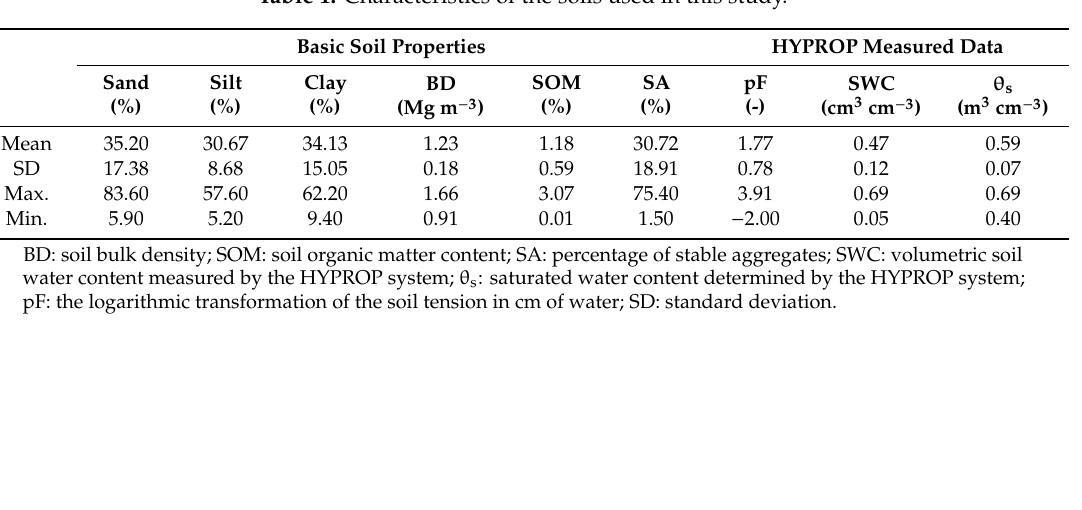
Figure 2. Soil texture of samples used in this study.